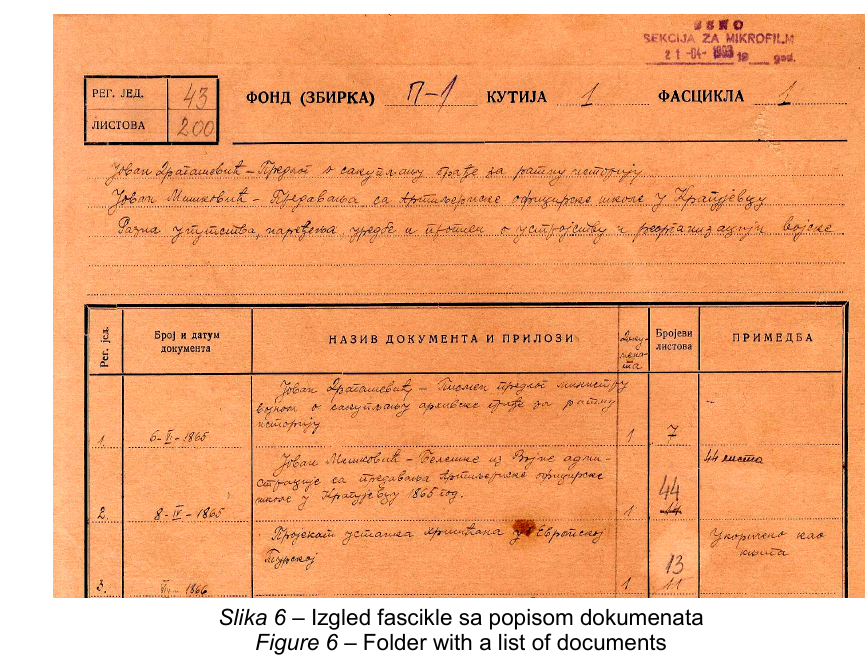
Figure 6 – Folder with a list of